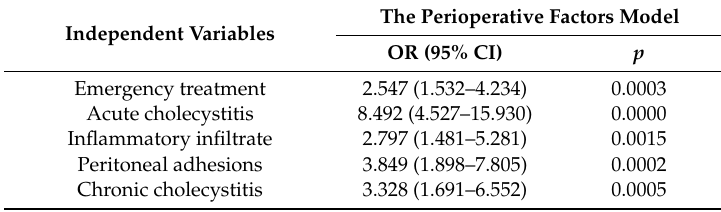
Table 6. Statistical significance of the factors in the regression model with perioperative factors.